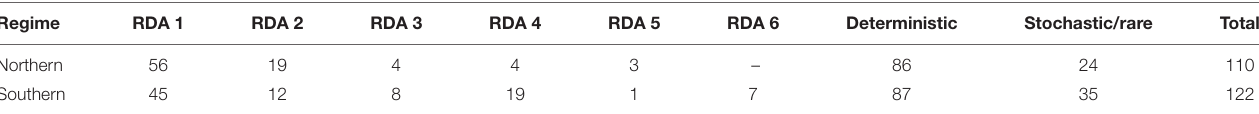
TABLE 1 | Number of bird species correlating significantly ( P ≤ 0.05) with significant RDA axes in time series models (i.e., deterministic species) of the northern and southern regimes.